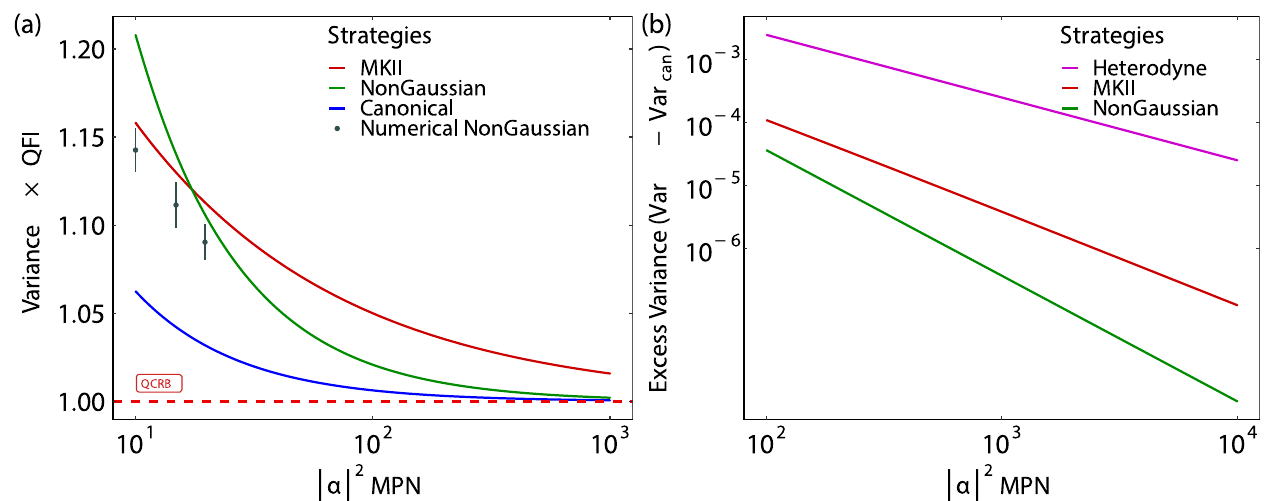
Fig. 1 Asymptotic variances for different phase measurements. a Holevo variance in the limit of large mean photon number (MPN) ∣ α ∣ 2 for the canonical phase measurement in Eq. (2), the most sensitive Gaussian measurement know to date (MK II) 21 in Eq. (1), and the non-Gaussian strategies in Eq. (3). The points show numerically calculated values for the non-Gaussian strategies in a region where the analytical expression is not valid. Error bars represent a 1- σ standard deviation. b Excess phase variance (Var[ ⋅ ] - Var ½ b ϕ CPM (cid:3) ) for Heterodyne, MKII, and non-Gaussian